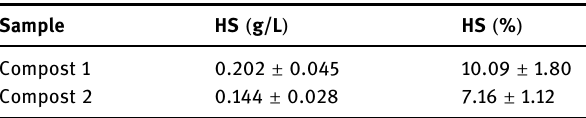
Table 2: Results obtained for HS quanti fi cation Sample HS ( g/L ) Compost